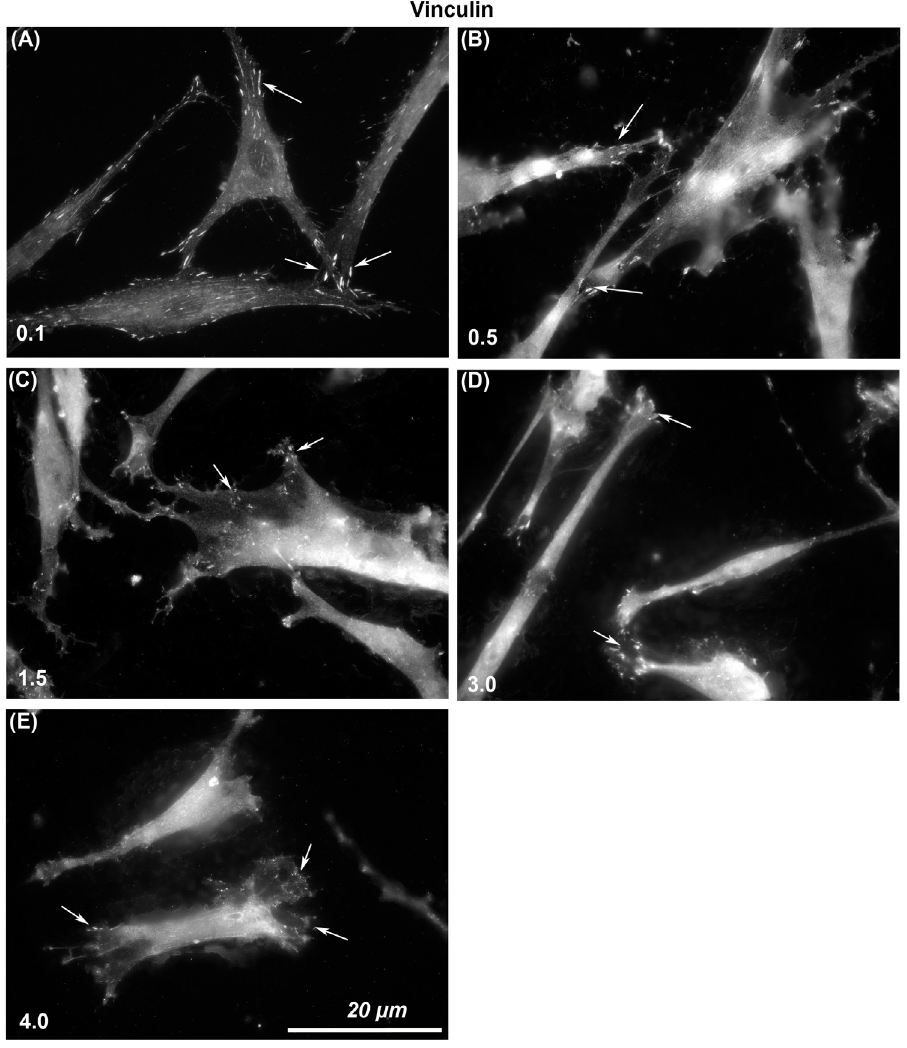
Figure 3. Influence of titanium substratum roughness on adhesion formation in HGFs. Cells were seeded on surfaces with an R a of ( A ) 0.1, ( B ) 0.5, ( C ) 1.5, ( D ) 3.0 ( E ) 4.0, and cultured for 24 h before being labeled with antibodies specific for vinculin. Size of adhesion declined with increasing substratum roughness. White arrows examples of adhesion formation.